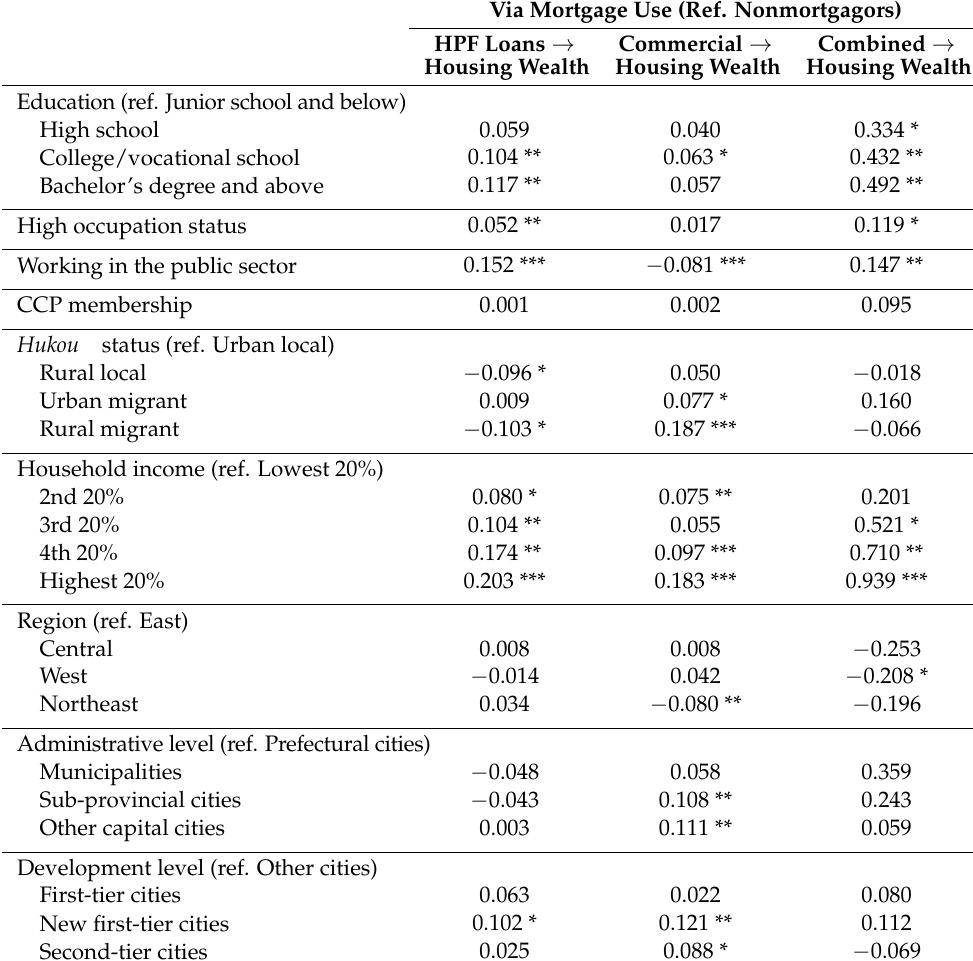
Table 3. Indirect effects of housing loan as a mediator on housing